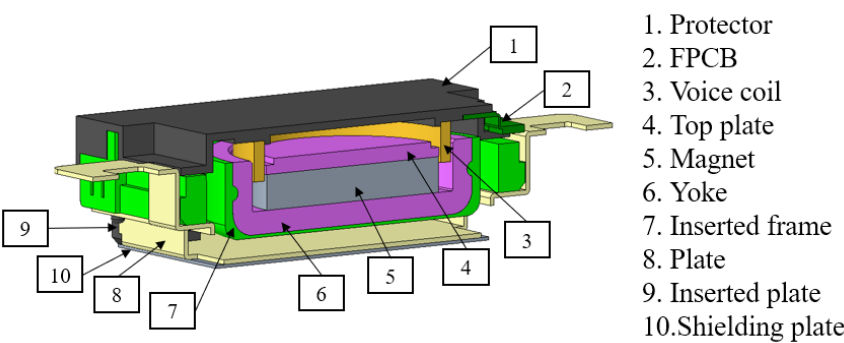
Figure 12. Magnetic shielding: ( a ) without shielding; ( b ) with shielding.